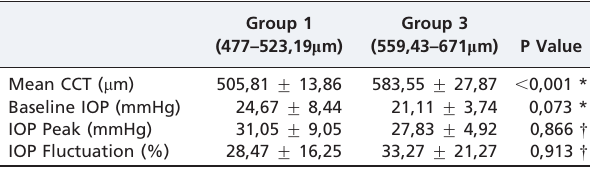
Table 2 - Results of Pachymetry and IOP measurements